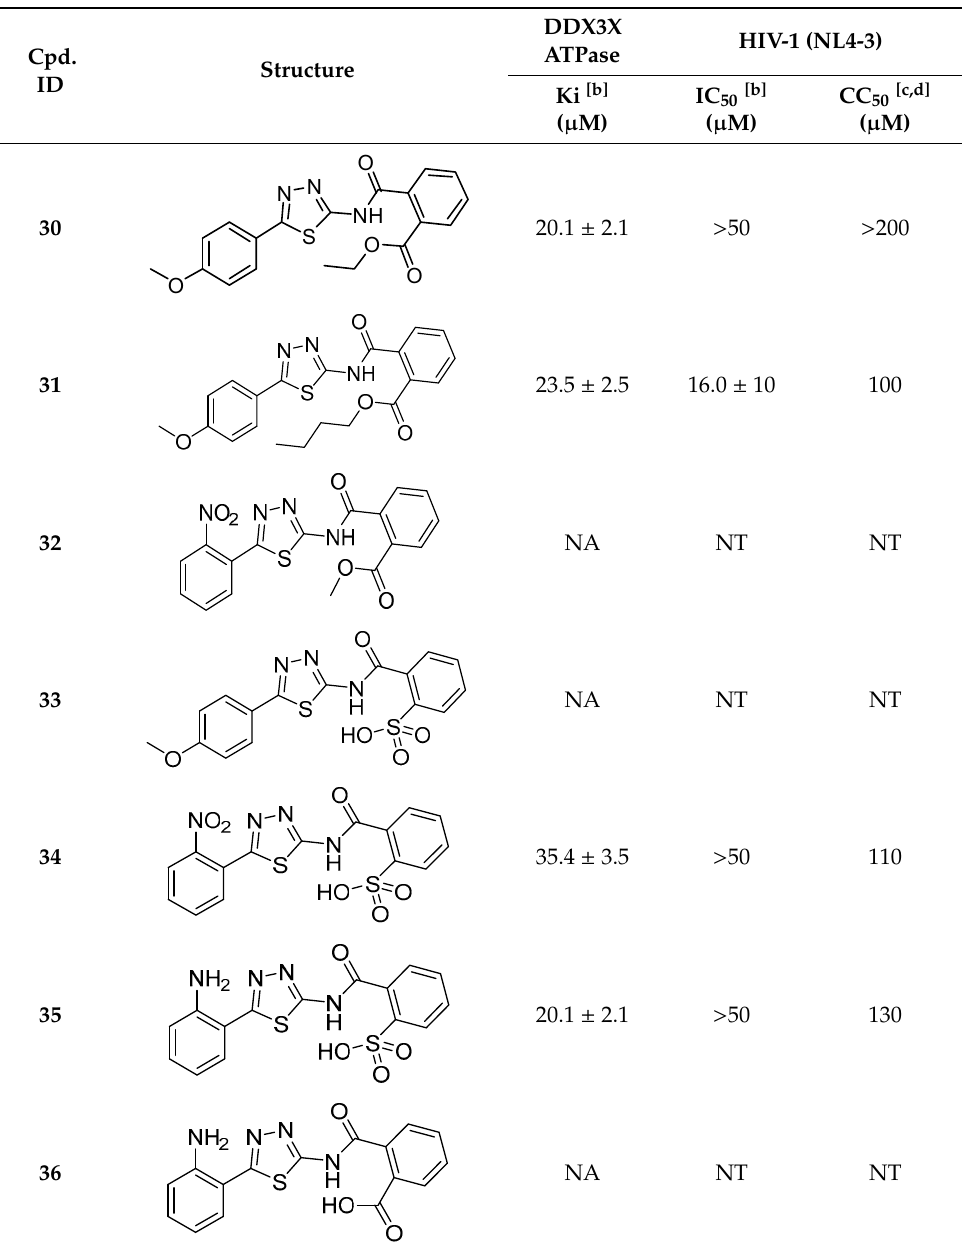
[a] Data represent mean ± standard deviation of three experiments. [b] Ki, apparent dissociation constant for inhibitor binding; IC 50 : half maximal inhibitory concentration or needed concentration to inhibit 50% viral replication. [c] CC 50 Cytotoxic concentration 50 or needed concentration to induce 50% death of non-infected cells. [d] Evaluated on H9 cells. NA: not active; NT: not tested.